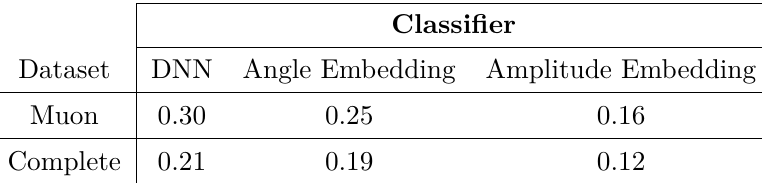
Table 2. Width ∆ cut for different classifiers and